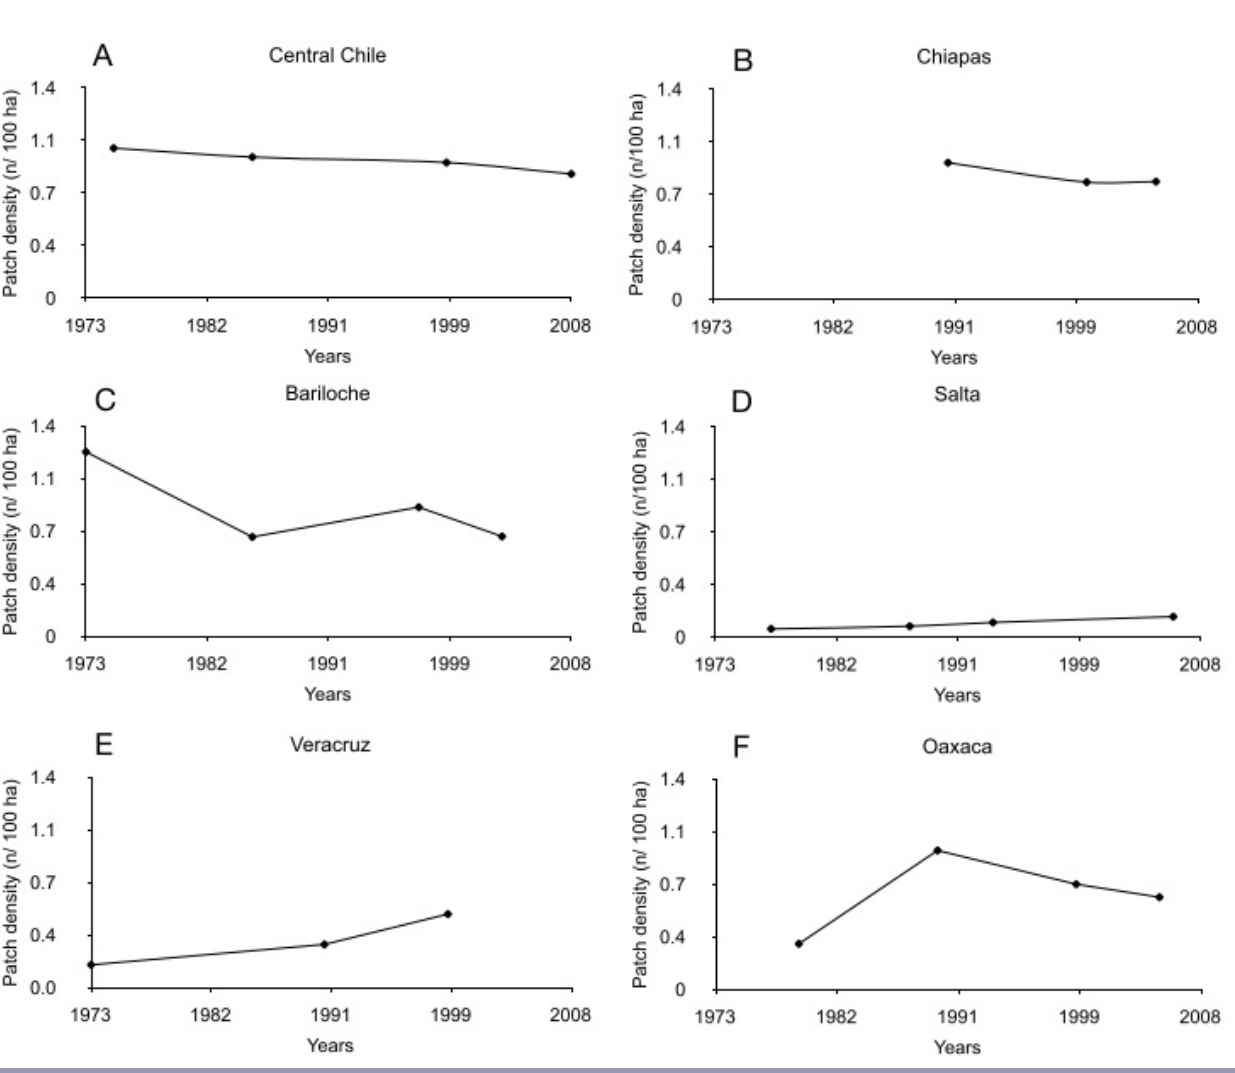
Fig. 2 . Temporal variation in forest patch density in the six study areas: (A) Central Chile, (B) Chiapas, Mexico, (C) Bariloche, southern Argentina, (D) Salta, northern Argentina, (E) Veracruz, Mexico, (F) Oaxaca, Mexico. Source: Newton and Tejedor